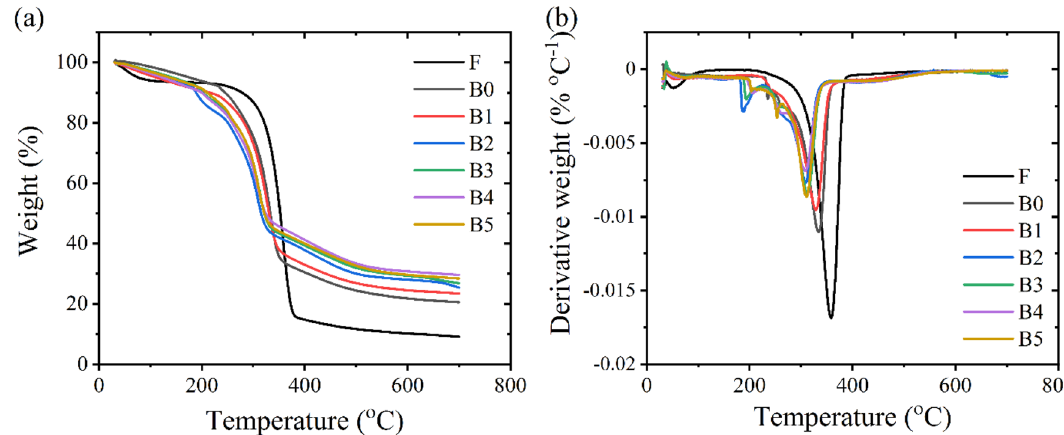
Figure 4. ( a ) Thermogravimetric (TG) and ( b ) derivative thermogravimetric (DTG) curves of purified water hyacinth fibers and cross-linked hydrogels with various concentrations of borax.